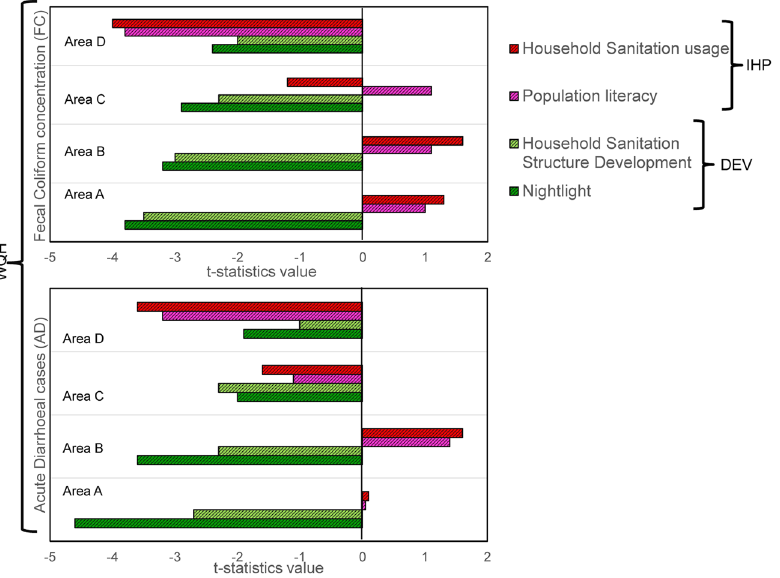
Figure 5. Bayesian VAR t-statistics value, showing impact of Sanitation and Economic development (DEV) and Improper Human Practices (IHP) on Water Quality and Health (WQH) for detailed study area A through D. Positive and negative t-statistics value indicates more direct and inverse, significant variance relationships, respectively.